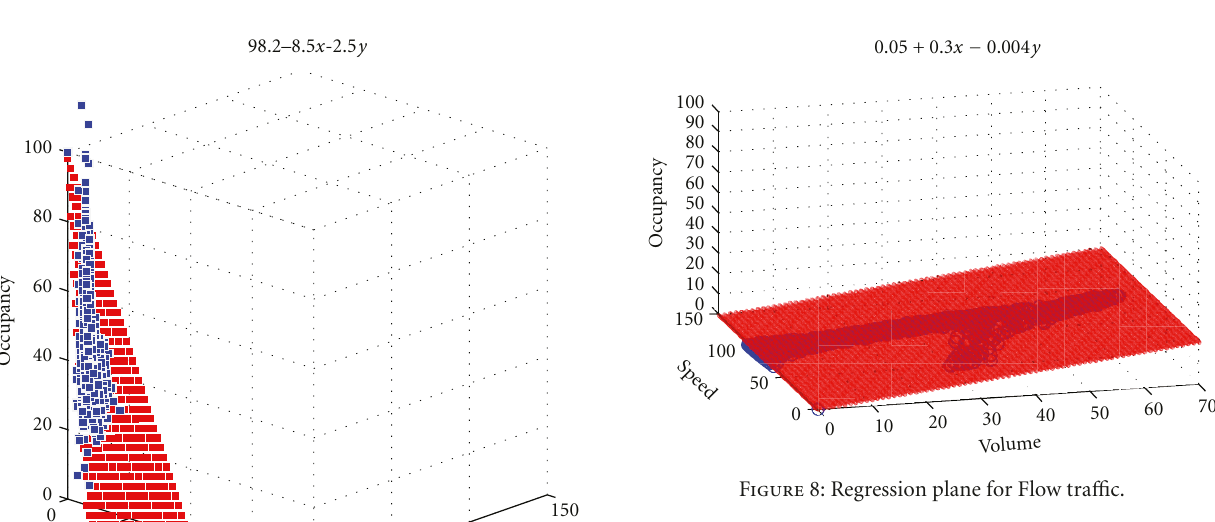
flow tra ffi c condition or not. On the contrary, occupancy goes to maximum value when speed approximates to zero in congested tra ffi c flow condition.